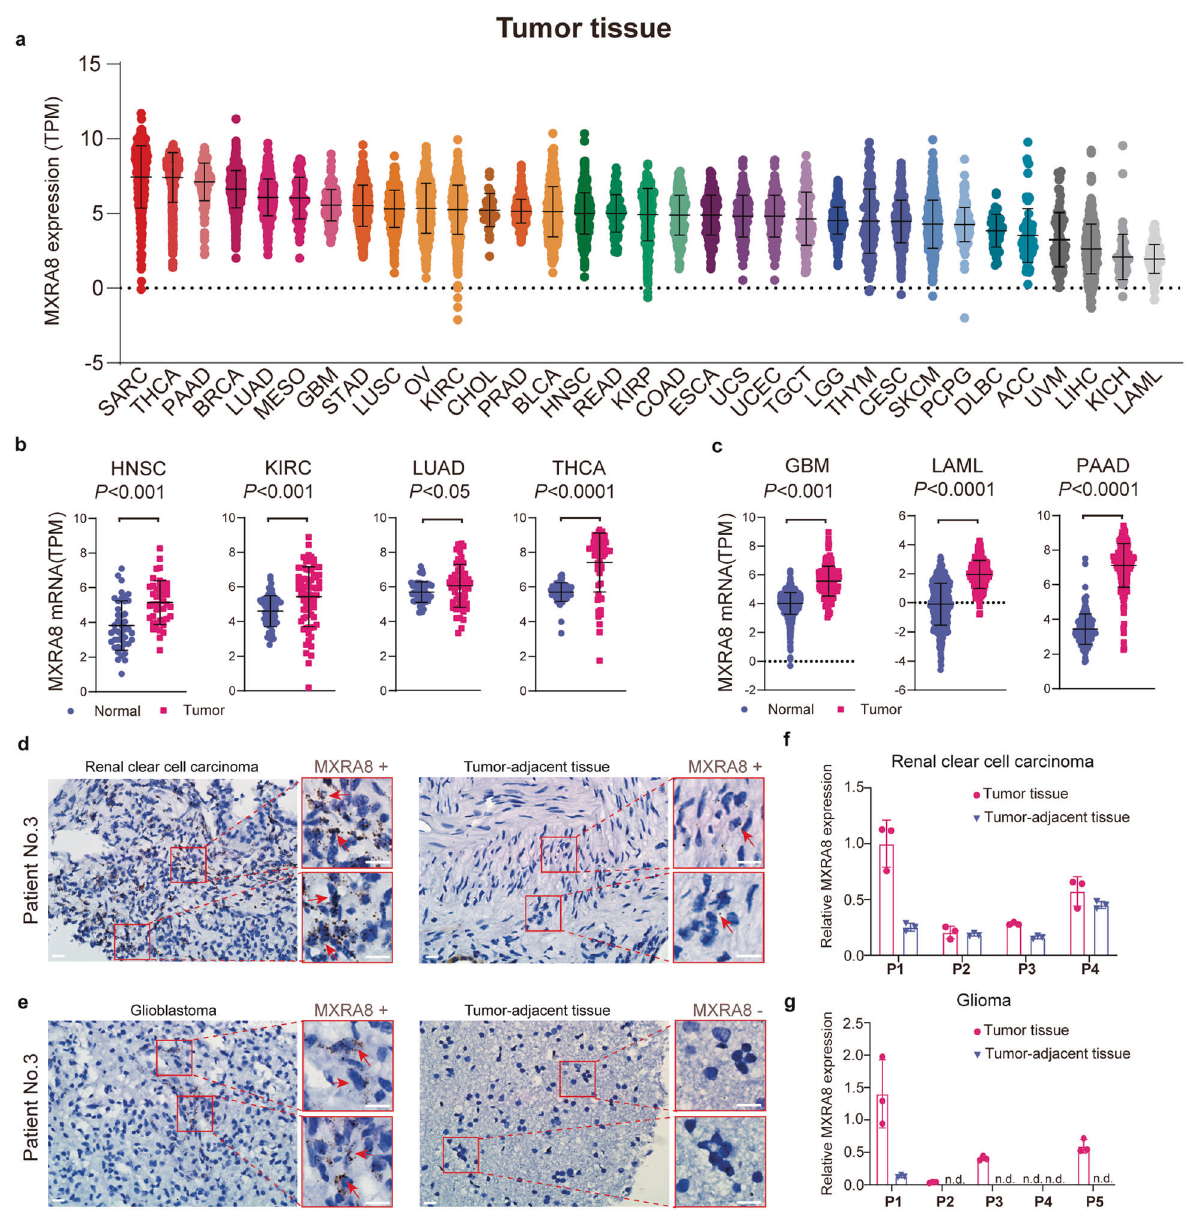
Fig. 4 MXRA8 is abundant in human tumor tissues but shows different expression levels among patients. a An overview of the RNA-seq data showing the MXRA8 expression levels in human tumor tissues according to the TCGA database. b Pan-analysis of the mRNA expression levels of MXRA8 in tumor tissues compared with the corresponding normal tissues in the TCGA database by paired t -test (HNSC, n = 43; LUAD, n = 60; KIRC, n = 58; THCA, n = 59). Each dot represents a single patient. c The expression levels of MXRA8 in tumor tissues from the TCGA database compared with those in the corresponding normal tissues from the TCGA and GTEX databases by two-tailed unpaired t -test. (GBM, n = 165 tumor versus 1146 normal tissues; PAAD, n = 178 versus 165; LAML, n = 173 versus 444). d , e RNA-scope detection of RNA in renal cancer ( d ) and glioma ( e ) with probes against MXRA8. Scale bars: 20 μ m. f , g The expression of MXRA8 in renal cancer and glioma was measured by RT-qPCR. n.d., not detectable; * P < 0.05; ** P < 0.01; *** P < 0.001